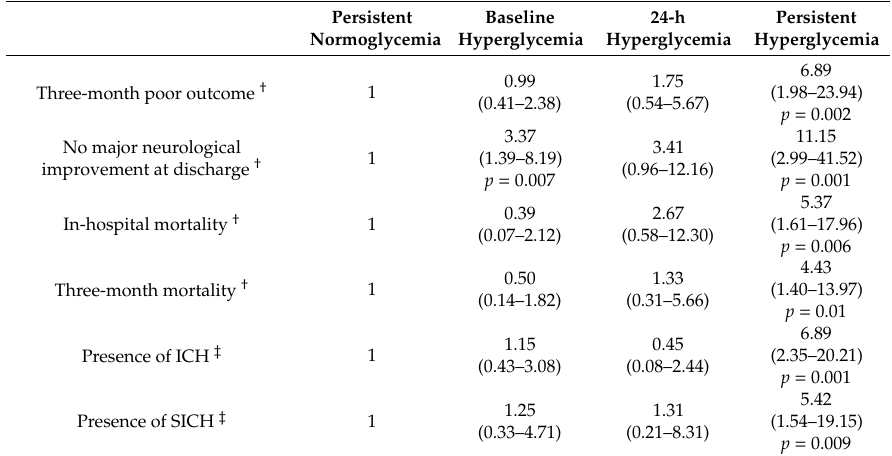
Table 3. Logistic regression model: adjusted ORs (95% CIs) of hyperglycemic patterns, in relation to the respective outcomes.